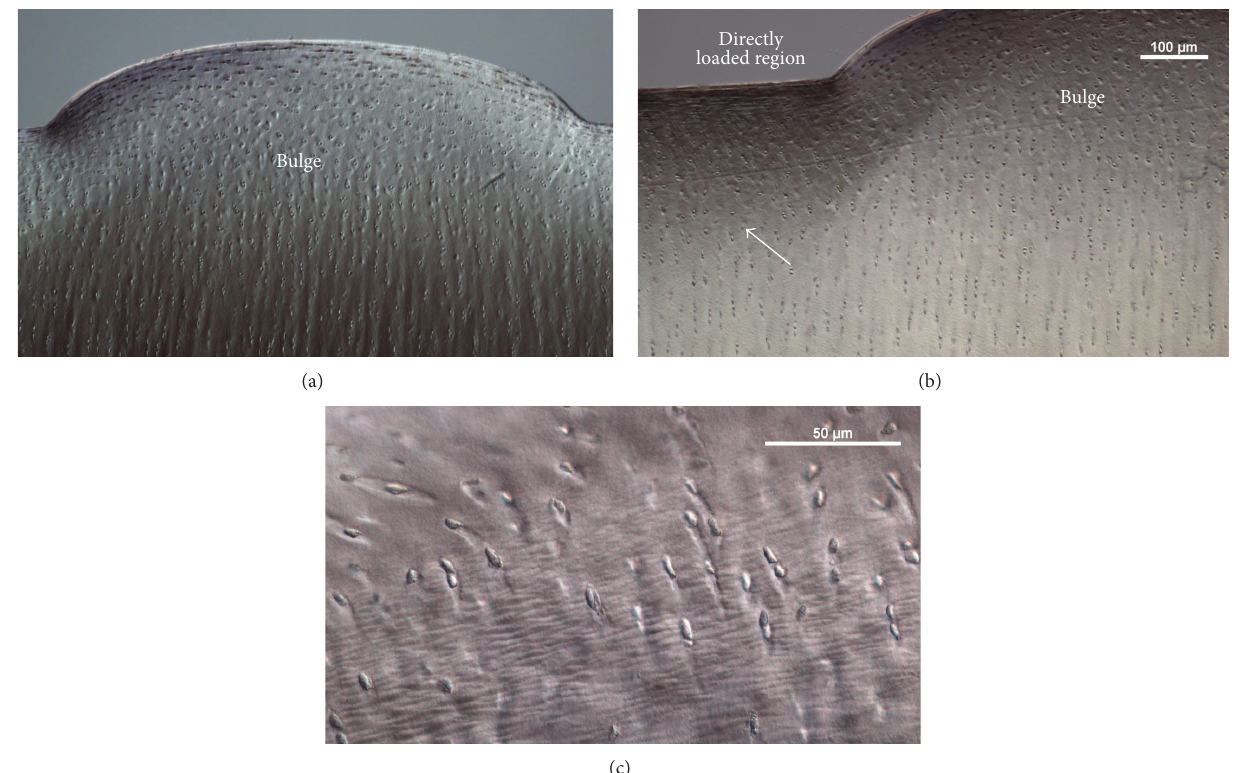
Figure 7: Images of a typical sample from the SR1 group. (a) shows the bulge and (b) shows how in a 1 MPa stress relaxation experiment shear bands are present in the directly loaded region (b). The arrow in (b) points to the region shown at higher magnification in (c). DIC